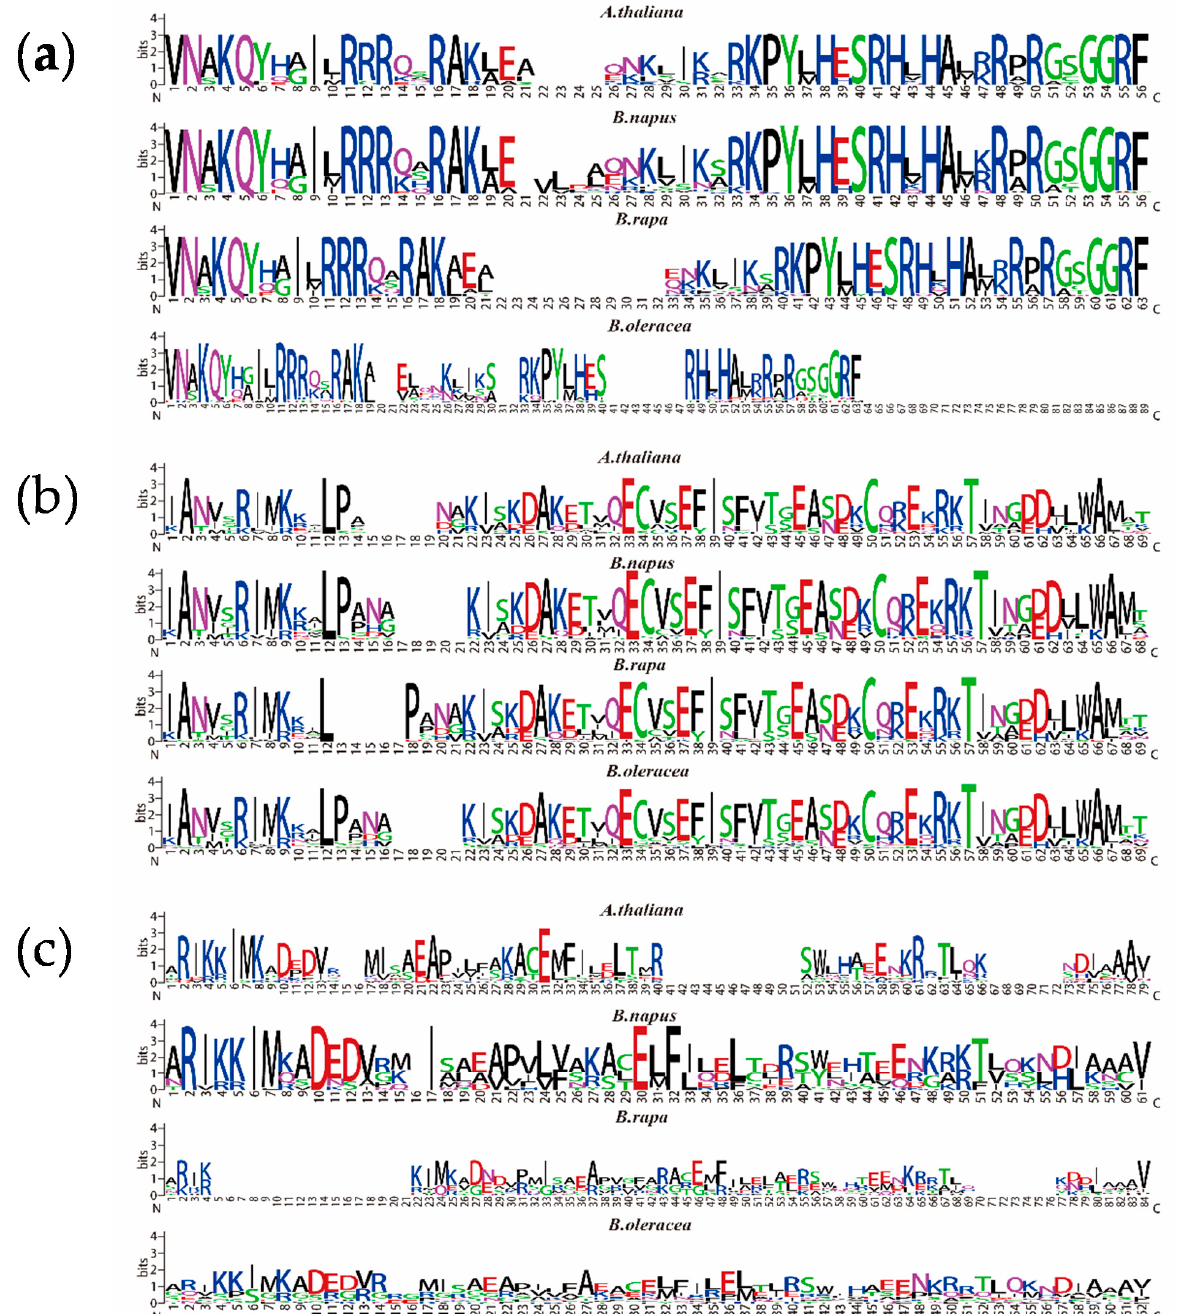
Figure 2. The conserved domains of three NF-Y subfamilies of B. napus , B. rapa , B. oleracea and Arabidopsis . The logo diagrams illustrate the consensus sequences of conserved domains of the three NF-Y subfamilies in different species, which are determined based on the multiple sequence alignments in each species: ( a ) The Nuclear Factor-YA ( NF-YA ) subfamily; ( b ) The Nuclear Factor-YB ( NF-YB ) subfamily; ( c ) The Nuclear Factor-YC ( NF-YC ) subfamily.